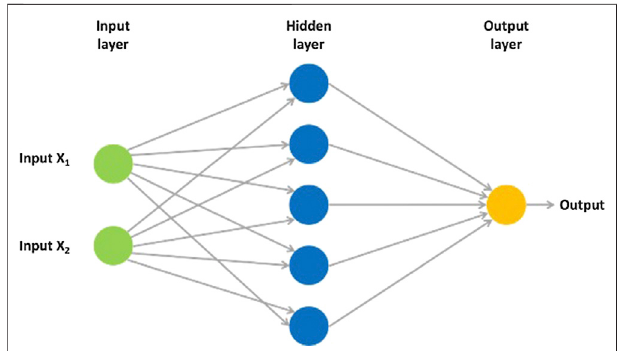
FIGURE 2 | Three-layer